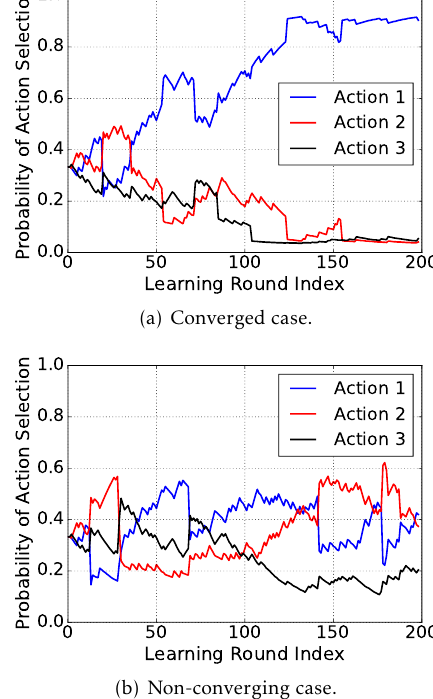
Figure 6. Two convergence cases of a learning phase in LiM. In (a), action 1 dominates at the end of the learning phase, while in (b), action 1 and action 2 still compete with each other in the end.